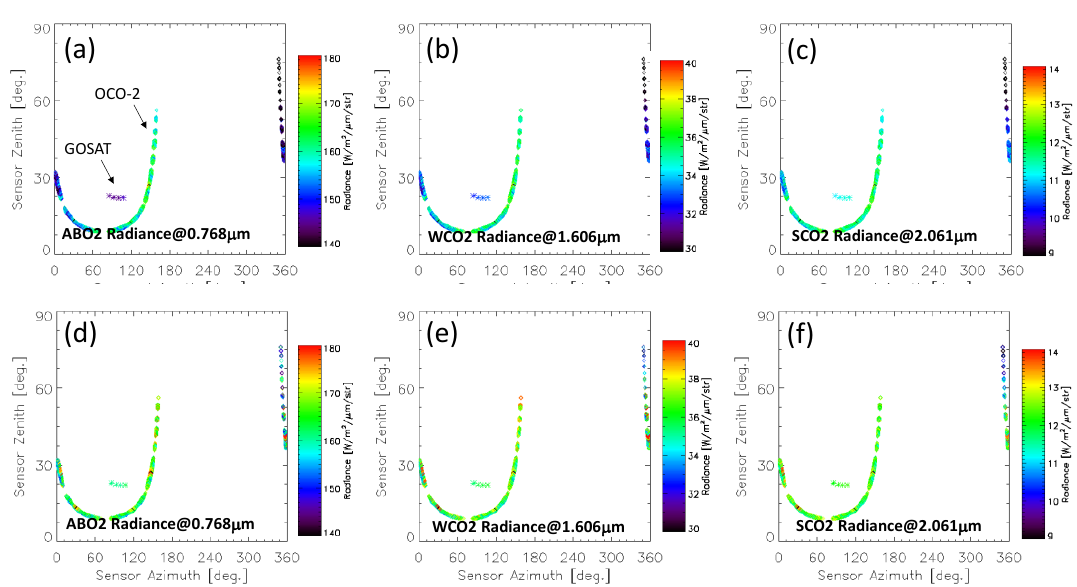
Figure 11. The OCO-2 and GOSAT spectra radiance against satellite azimuth and zenith angles during RRV target observations on 1 July 2015. The plots are same as the Figure 10.